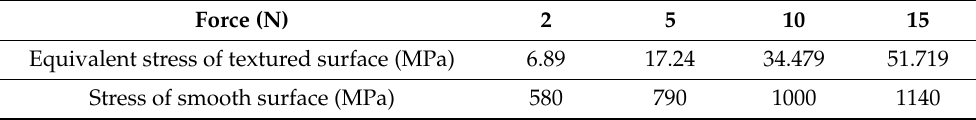
Figure 10. The result of ( a ) the deformation and ( b ) stress of textured surface under the load of 15 N. Table 1. The results of the deformation of the pocket-textured surface under different loads. Force (N) Deformation of textured surface (m/10 − 8 )